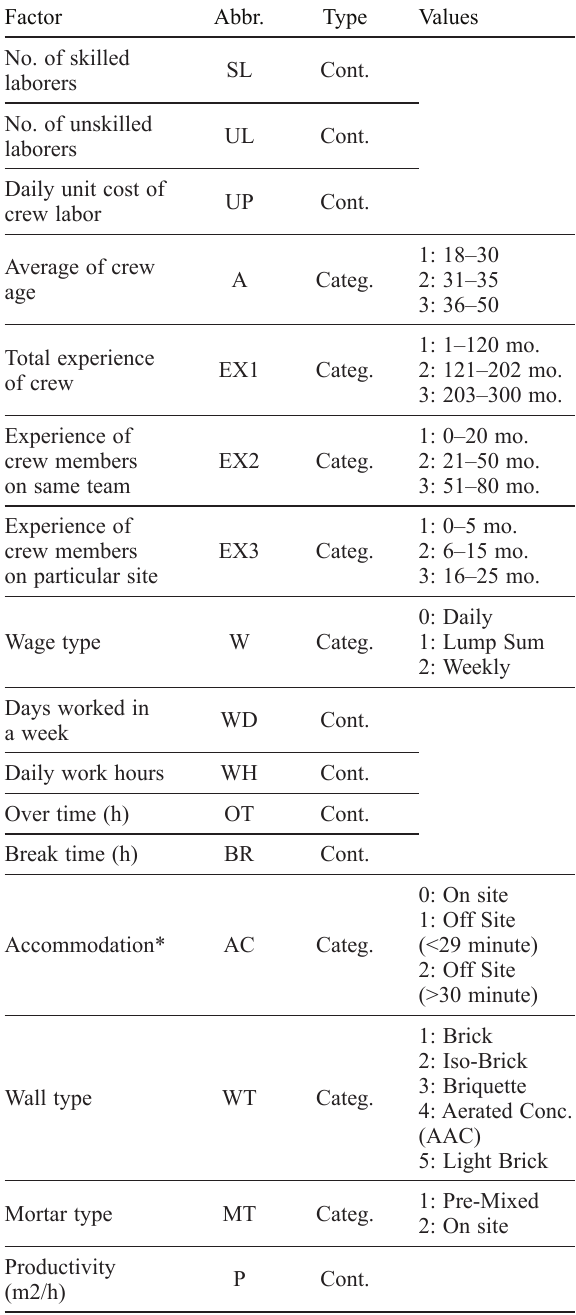
Table 1. Crew productivity factors considered in the study Factor